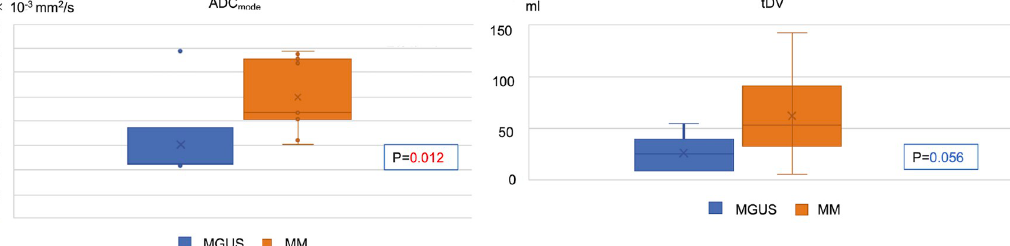
Fig 2. Stages of plasmacytoid tumor and apparent diffusion coefficient (ADC) value. The ADC mode was significantly higher in patients with MM than in those with MGUS (1.00 ± 0.28 × 10 − 3 mm 2 /s vs. 0.61 ± 0.38 × 10 − 3 mm 2 /s). tDV tended to be higher in patients with MM than in those with MGUS (62.3 ± 40.3 ml vs 25.9 ± 18.1 ml). MM, multiple myeloma; MGUS, monoclonal gammopathy of undetermined significance; tDV, total diffusion